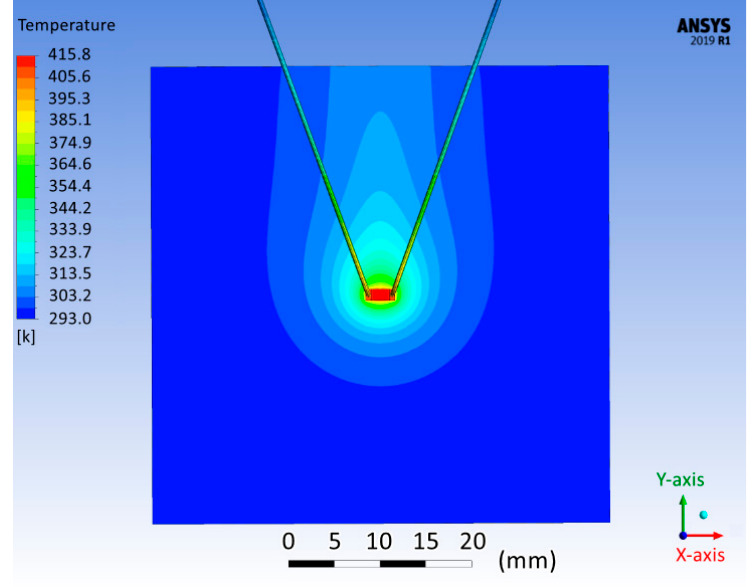
Figure 6. Heat distribution on the surface of the fiberglass base in the simulation model.